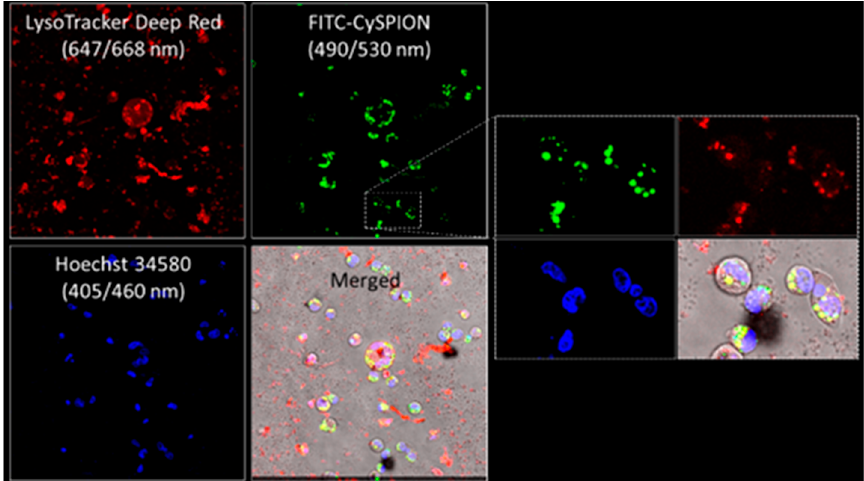
Figure 5. Confocal micrographs of Npc1-deficient CHO after incubation with 0.1 mg/mL FITC-CySPION for 72 h showing co-localization, with Pearson’s coefficient of 0.37, between FITC-CySPION (green) and LysoTracker Deep Red within the lysosomal compartments (red) within the ROI pre- produced on the right. The used excitation wavelengths and fluorescence maxima are indicated in the figures. The field of view is 290 × 290 µ m 2